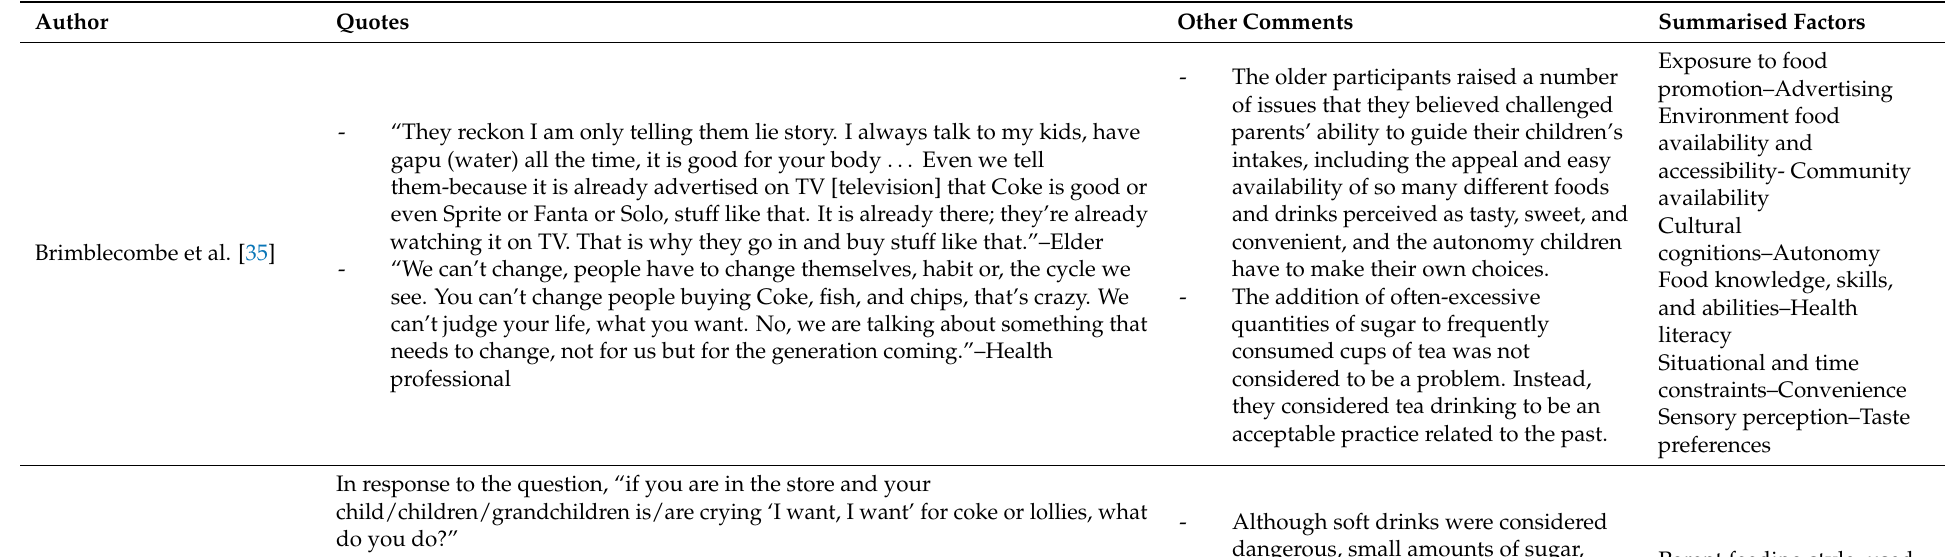
Table 5. Factors influencing SSB consumption extracted from the included qualitative